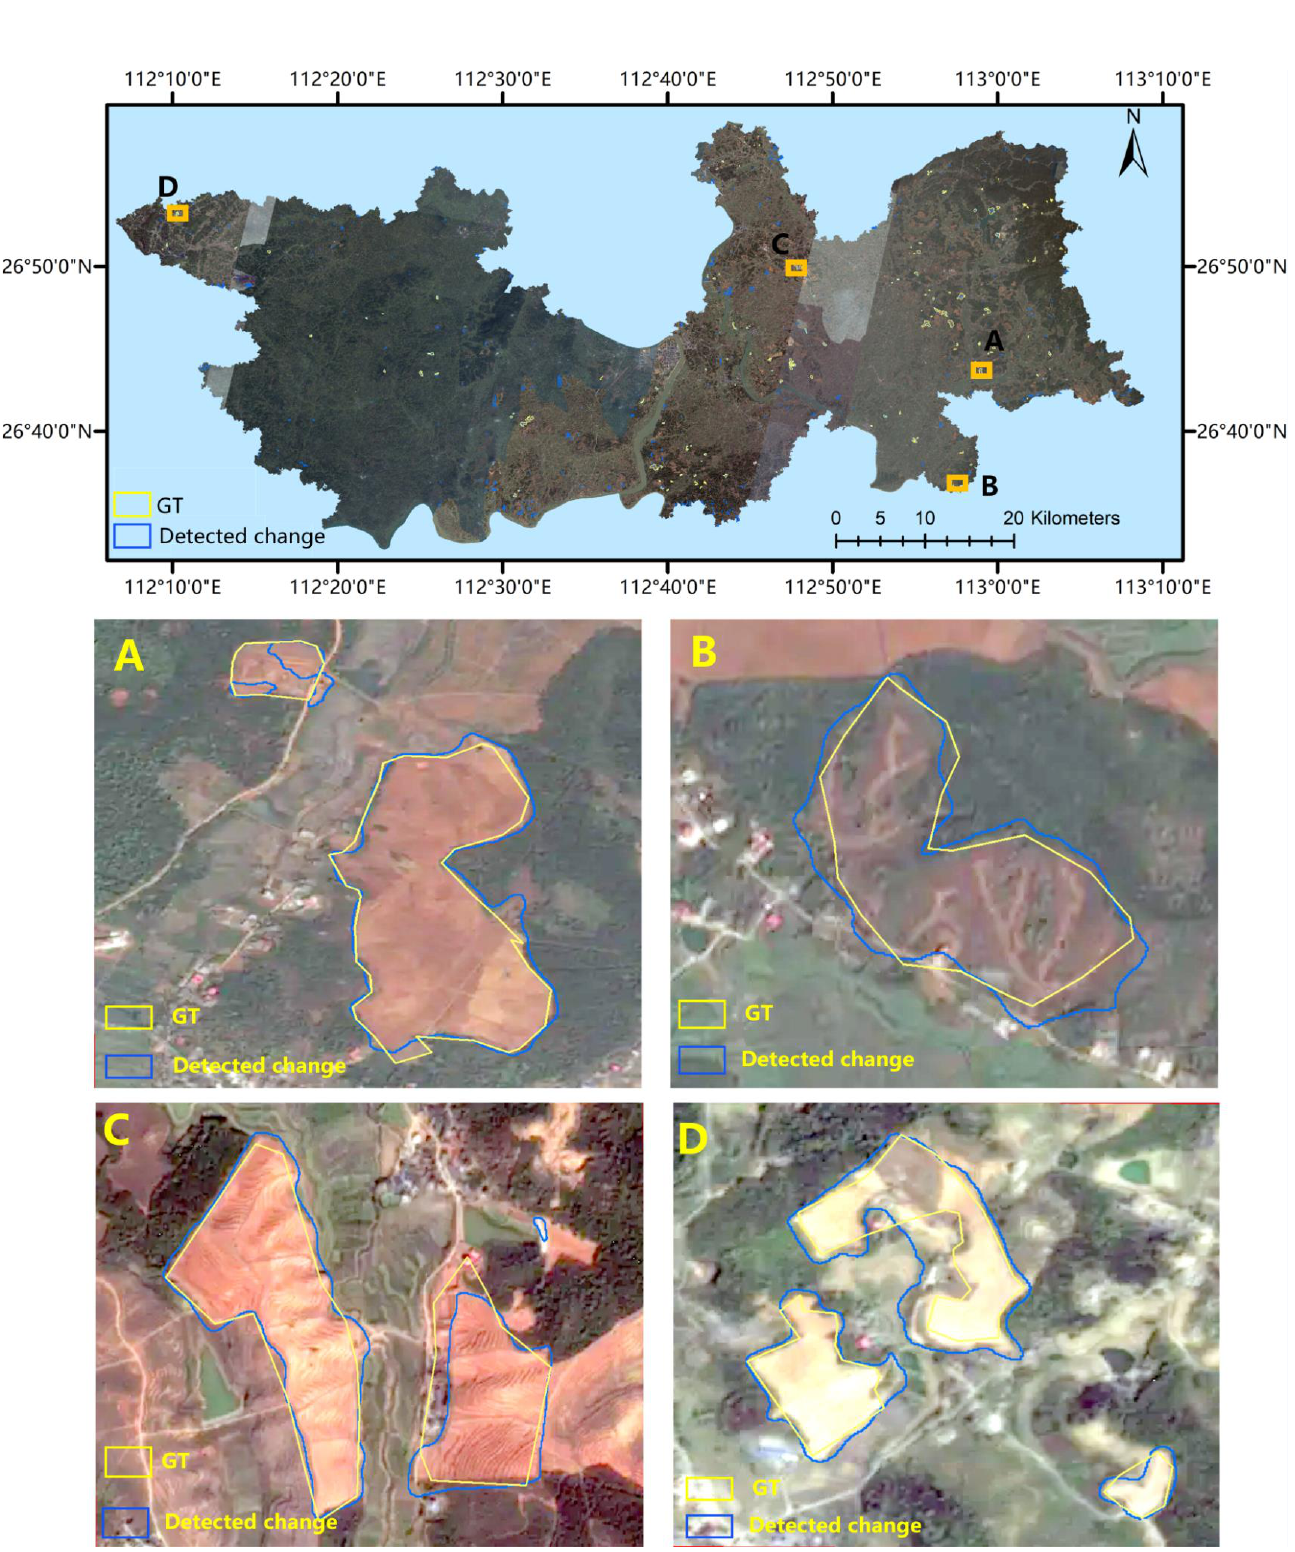
Figure 7. Deforestation detection for Hengyang city.